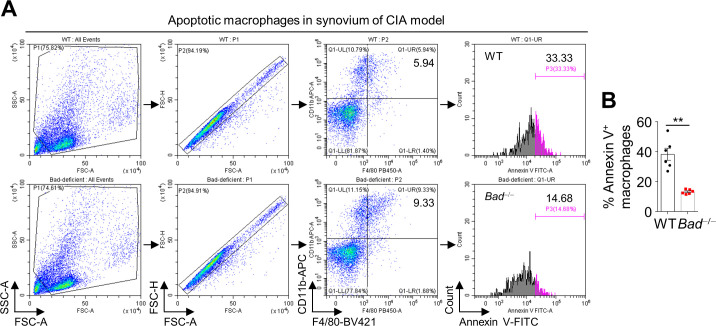
Bad loss protects synovial macrophages from apoptosis in collagen-induced arthritis (CIA).(A) Apoptotic synovial macrophages from wild-type (WT) and Bad−/− mice in CIA model were analyzed by flow cytometry by staining Annexin V. (B) Quantification of the ratio of Annexin V positive synovial macrophages in WT (n = 6) and Bad−/− (n = 6) mice in CIA model. All data are presented as mean ± SEM; dots represent individual mice. Significant difference was analyzed by unpaired Student’s t-test, **p<0.01.